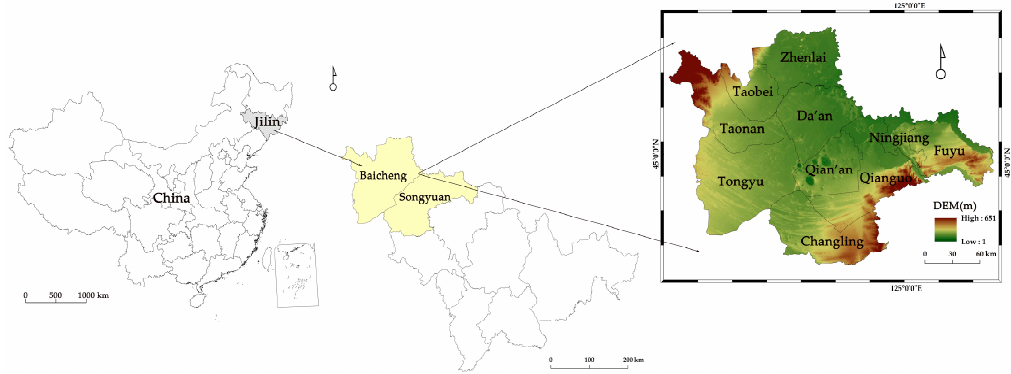
Figure 1. Locations of study area.